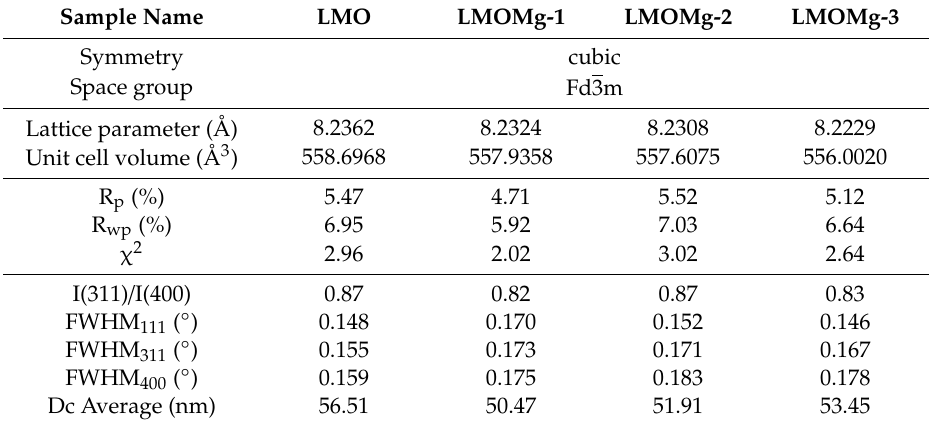
Table 6. Rietveld refinement, crystal parameters, and crystallite size for LiMg x Mn 2 − x O 4 (x = 0.00, 0.02, 0.05, 0.10)